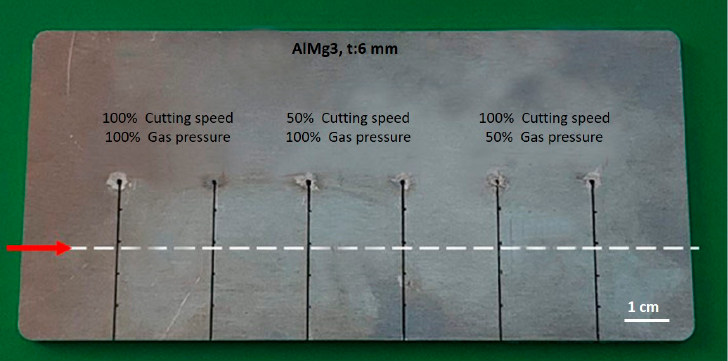
Figure 2. Schematic of comb-like configuration used for tests.